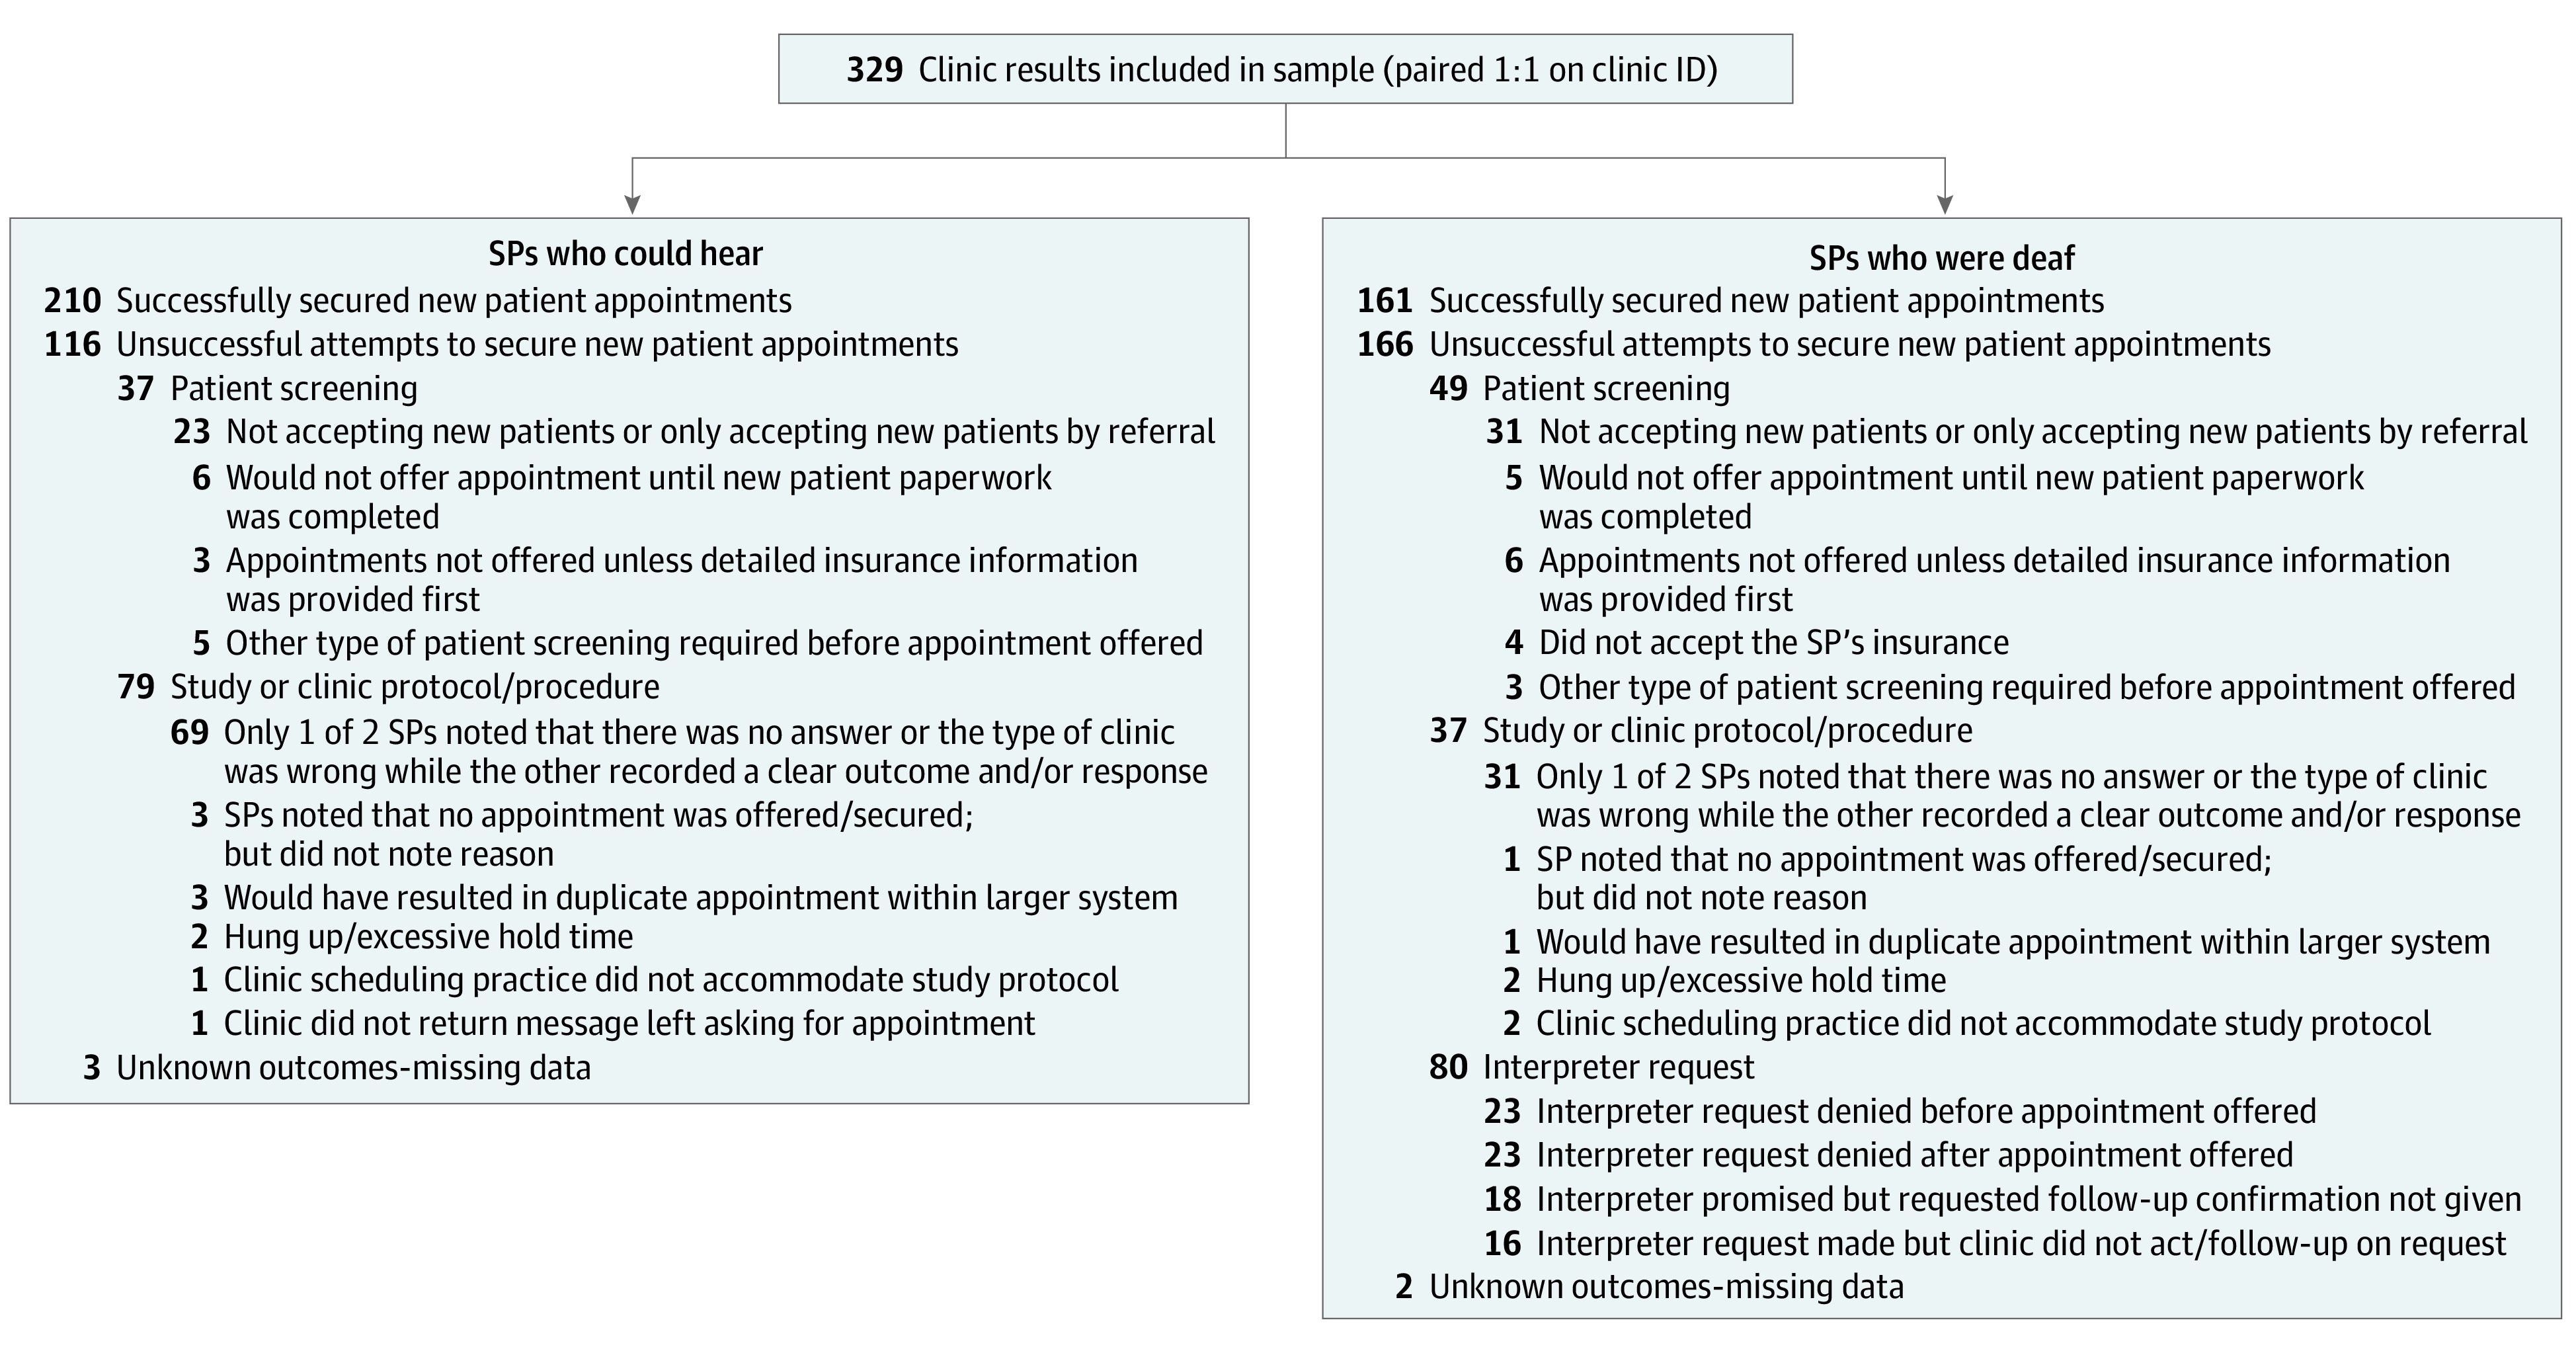
Outcomes of New Patient Appointment RequestsID indicates identification; SP, simulated patient.